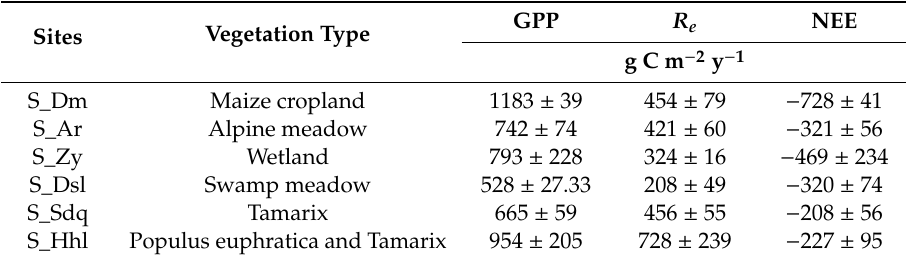
Table 2. Annual mean GPP, R e , NEE, and the corresponding standard deviations of di ff erent ecosystems based on the six flux sites between 2014 and 2016.